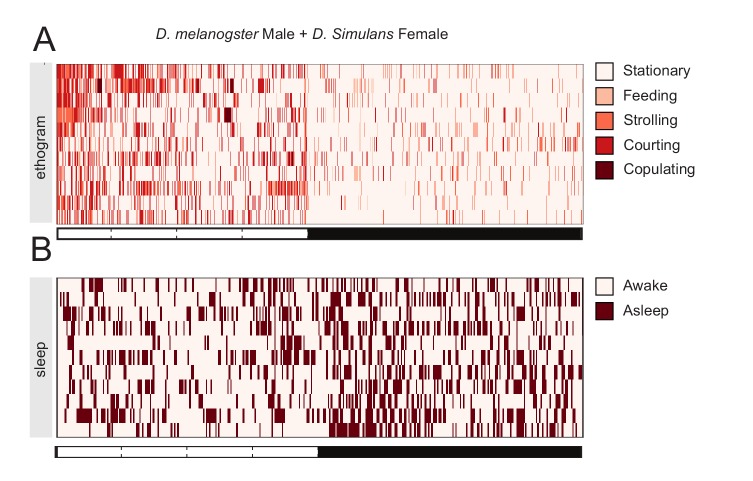
Inter-specific male-female interaction.(A) Representative behavioural classification of the interaction day for coupling of a male D. melanogaster with a female D. Simulans (N = 11). Each row shows the behavioural profile of a male during 24 hr of social interaction. (B) Human assisted behavioural scoring of single male fly sleep of the same data set shown in A.